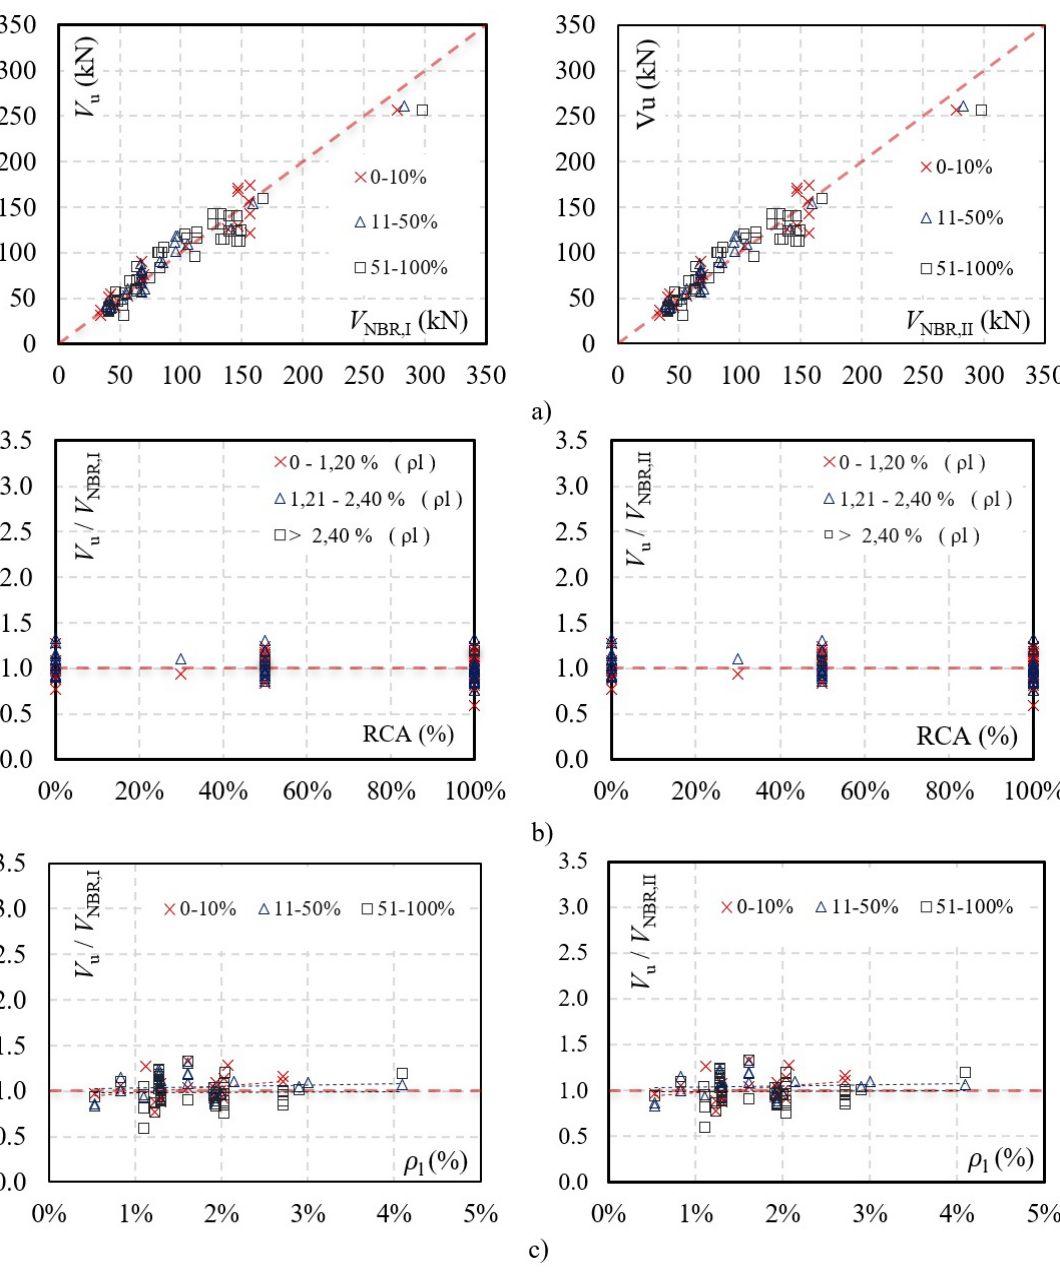
Figure 9. Comparison between the experimental and theoretical for the database of beams without stirrups